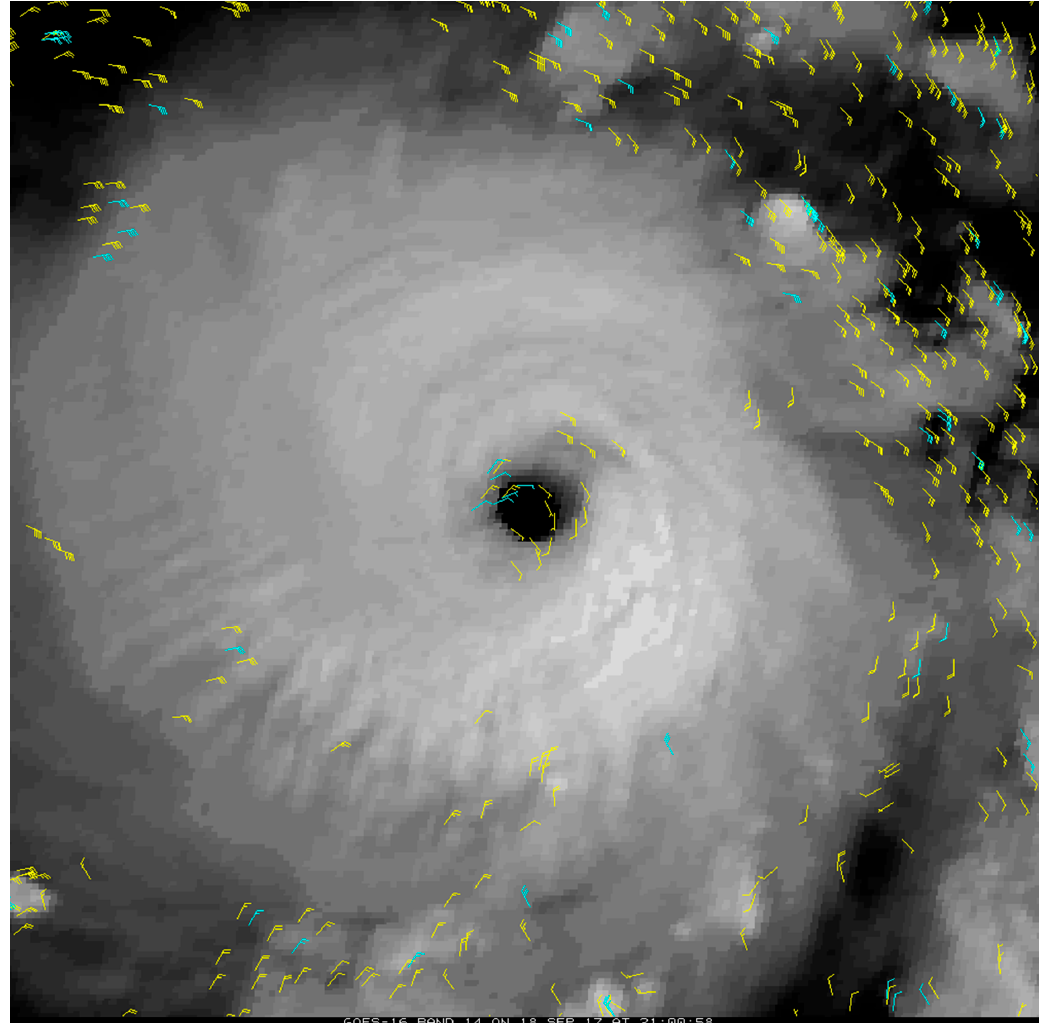
Figure 2. Atmospheric motion vectors (AMVs) (IR and CTWV) generated from GOES-16 imagery during Hurricane Maria at 2100 UTC on 18 September, 2017. The cyan wind flags were derived using full-disk processing settings such as currently done in NOAA/NESDIS operational AMV production. Decreasing the spacing between targets from 15 to 5 pixels yields the increase in AMVs as shown in yellow. The height assignments for all of the plotted AMVs are in the 100–250 hPa range in this and all following plots.